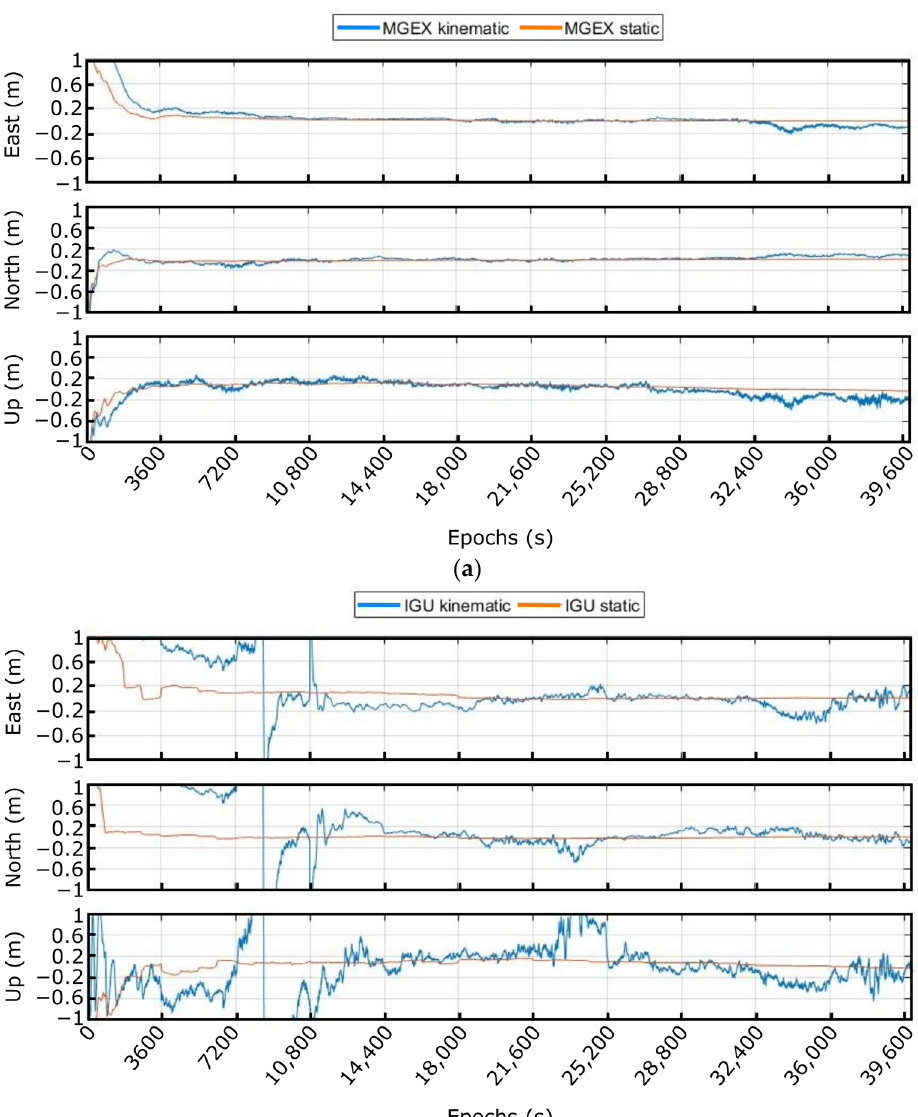
Figure 9. Post-processing results using ( a ) MGEX and ( b ) IGU precise products.